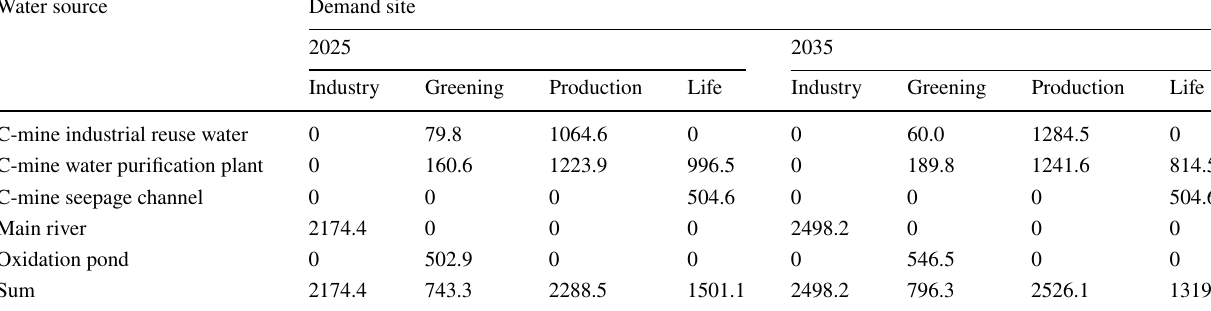
Table 7 Results of water resources allocation in the c-mine area in 2025 and 2035